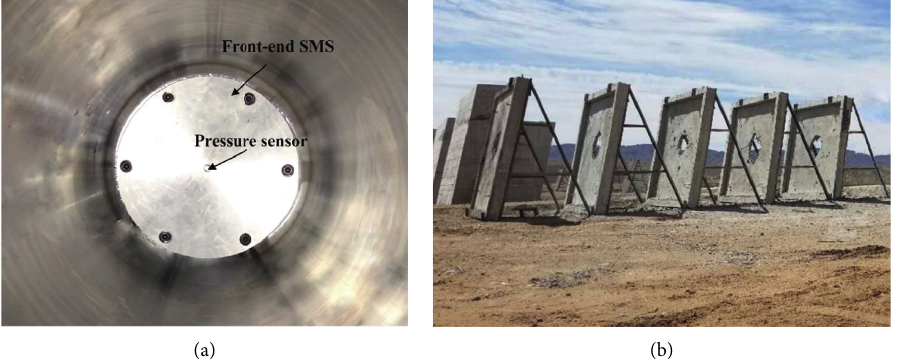
Figure 12: The MTP experiment. (a) Installation structure of the front-end SMS prototype. (b) Concrete targets.